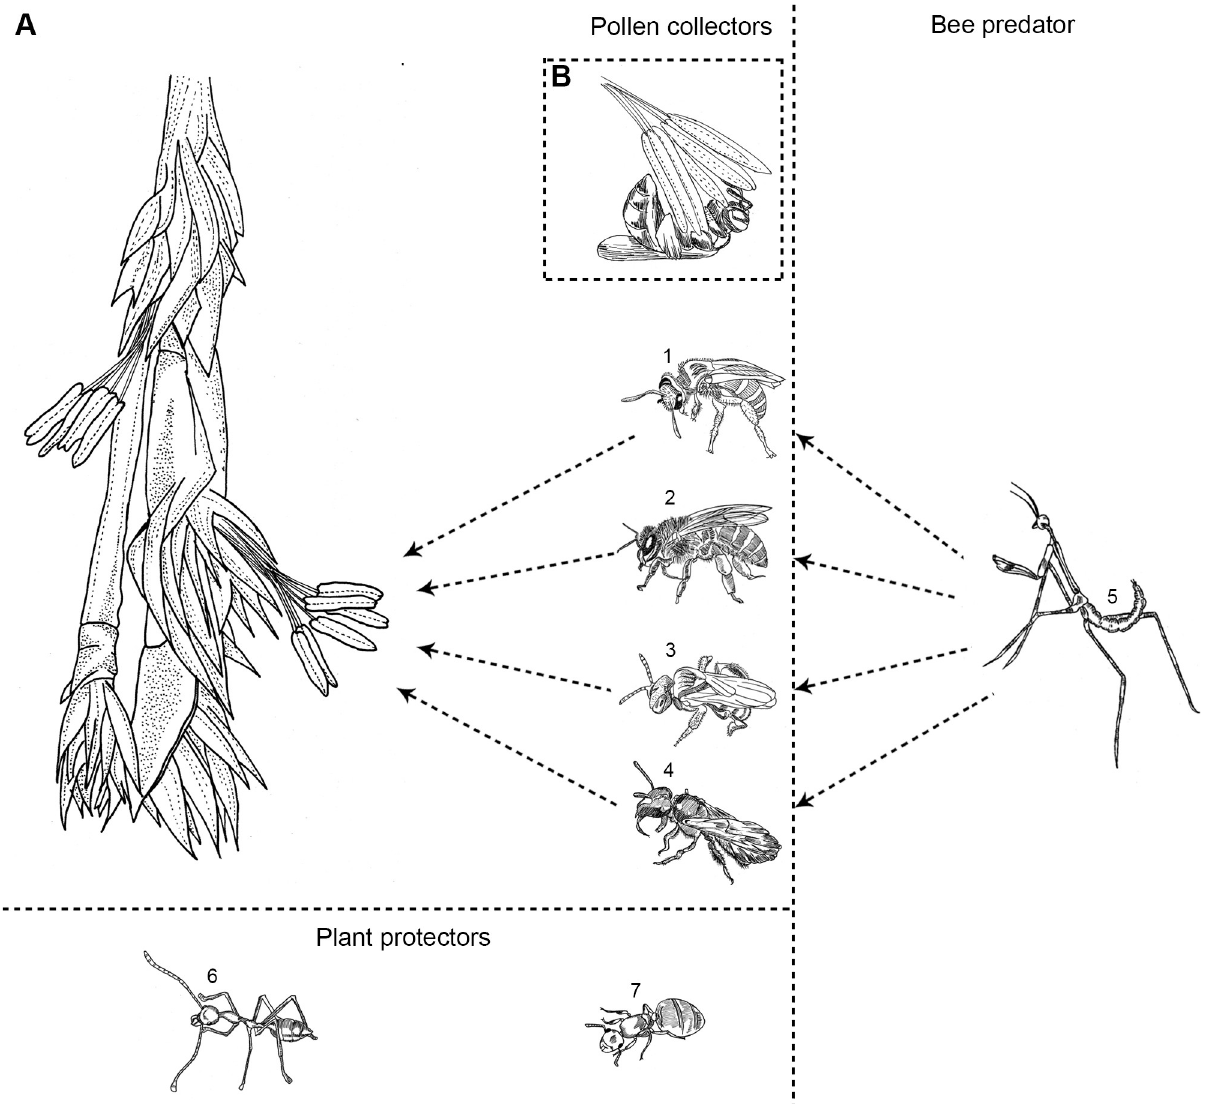
Fig 2. Diagrammatic sketch of pollen collectors, bee predators and plant protectors in M . baccifera . A. Part of inflorescence showing stamens, B. Bee visitation on stamens of a floret, 1–4 Pollen collectors, 1. A . cerana indica , 2. H . taprabonae , 3. B . cupulifera , 4. T . iridipennis ; 5. Bee predator, Mantis E . indica ; 6–7. Plant protectors, Ants, 6. O . smaragdina , 7. C . biroi .